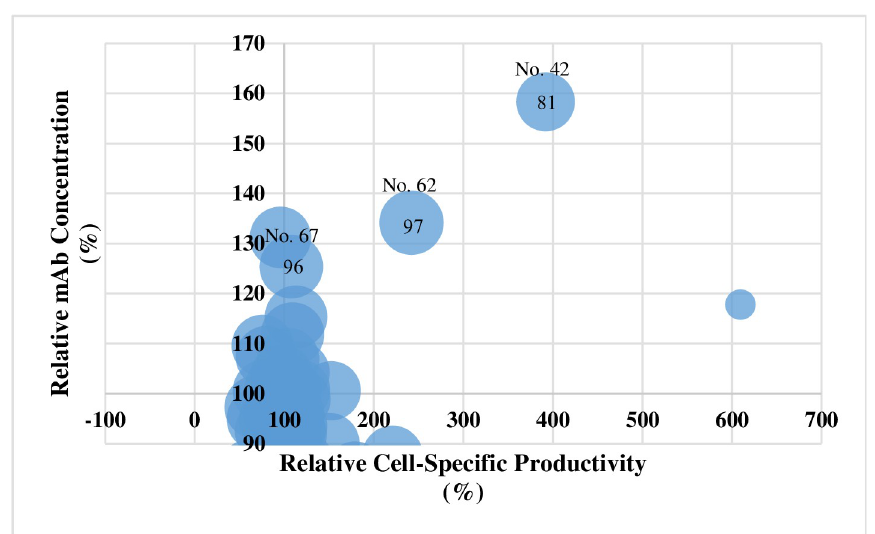
Fig 2. Relative mAb concentration and cell-specific productivity increased with the addition of the chemical compounds. The numbers in and above the circles indicate viability and the sample’s ID number, respectively.